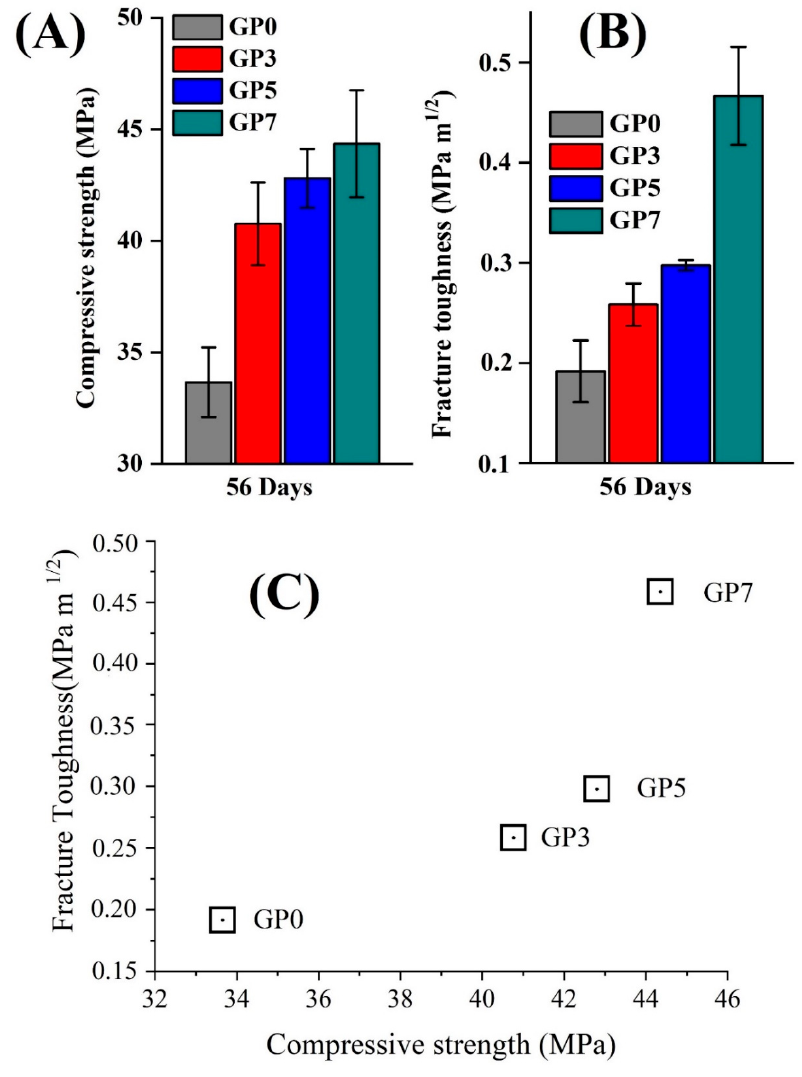
Figure 2. Different geopolymer specimens in terms: ( A ) Compressive strength; ( B ) fracture toughness; ( C ) variation of fracture toughness with compressive strength.